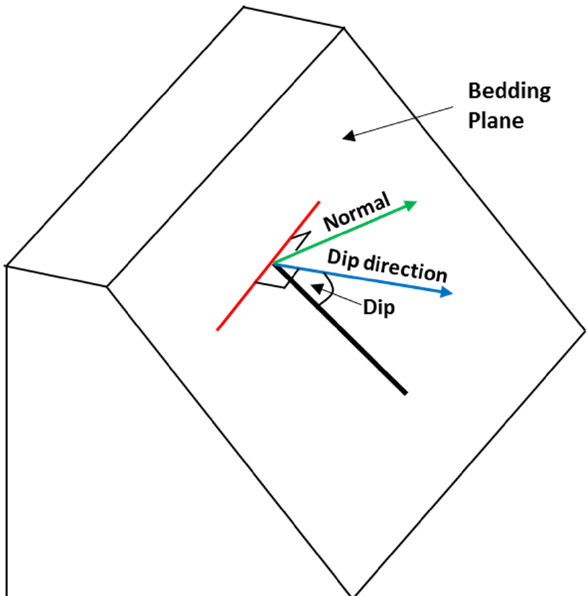
Figure 3. Illustration of dip, dip direction, and normal direction of a bedding plane.